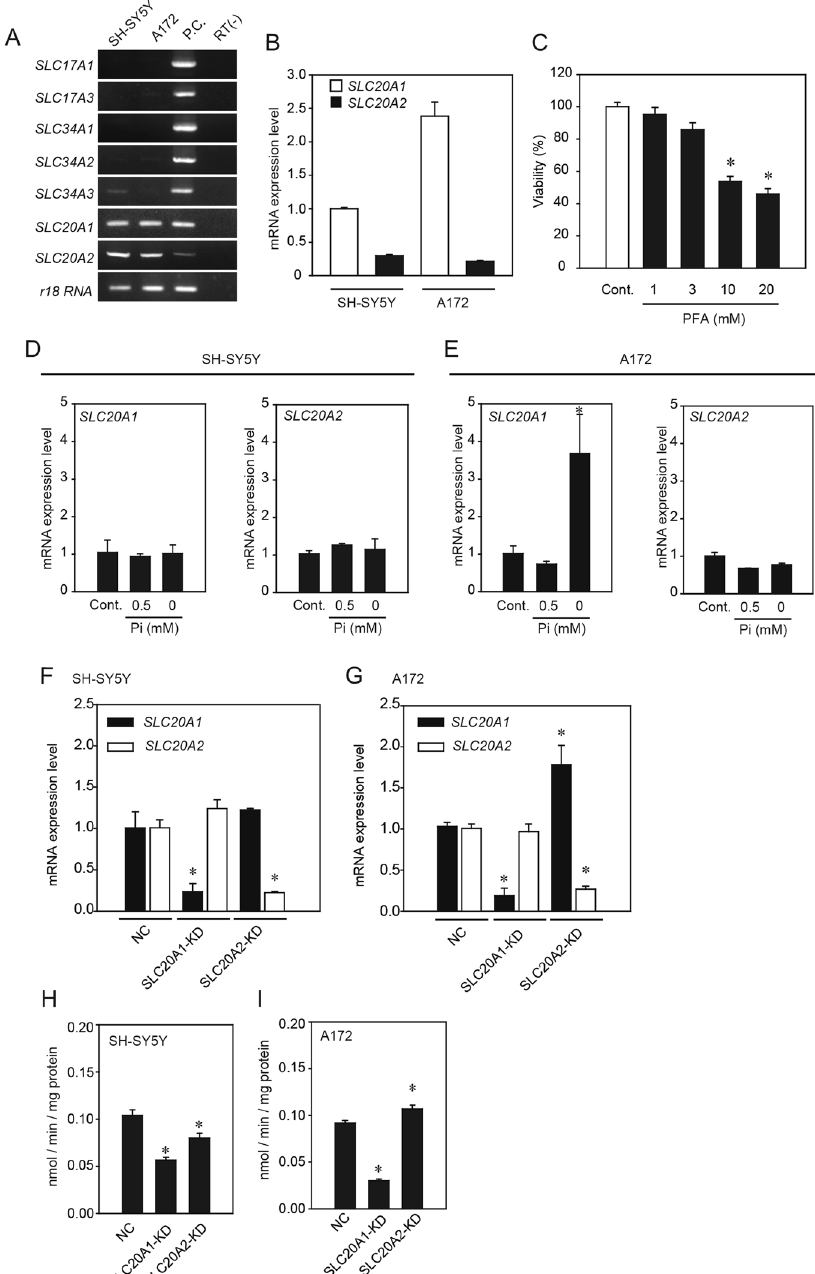
Figure 2. Effects of low Pi loading on type-III NaPiT mRNA expression. cDNA reverse transcribed from the mRNA of SH-SY5Y or A172 cells was used as a template for the RT-PCR and qRT-PCR assays. ( A ) Expression of NaPiT mRNA in SH-SY5Y or A172 cells. For each amplification reaction, positive control reactions (PC) were performed using cDNA templates from the kidney (except for SLC34A2 ) or lung (for SLC34A2 ). Negative control reactions lacking RT reactions (RT-) were also performed to exclude the possibility of genomic DNA contamination. The sequences of primer sets are shown in Table 1. ( B ) The TaqMan-based qPCR assay using SLC20A1 and SLC20A2 probes. Data were normalized to the amount of 18s ribosomal RNA ( 18s rRNA ), and results are expressed as the fold increase compared with that in the SH-SY5Y cells (mean ± SEM; n = 3). ( C ) Effect of PFA on cytotoxicity. ( D , E ) At 24 h after low Pi loading treatment, mRNA expressions of SLC20A1 and SLC20A2 was analyzed using the TaqMan-based qPCR assay. ( F , G ) SH-SY5Y and A172 cells were transiently transfected with SLC20A1 or SLC20A2 siRNA. At 24 h after transfection, mRNA expressions of SLC20A1 and SLC20A2 were analyzed using the TaqMan-based qPCR assay. ( H , I ) The Pi uptake assay was carried out in SLC20A1 - and SLC20A2 -suppressed cells. Data were normalized to the amount of 18s rRNA , and results are expressed as the fold increase compared with that at 1 mM Pi ( D , E ) or in NC ( F – I ) (mean ± SEM; n = 3). The significance of any difference was determined using ANOVA followed by the Bonferroni/Dunn post-hoc test ( * p <